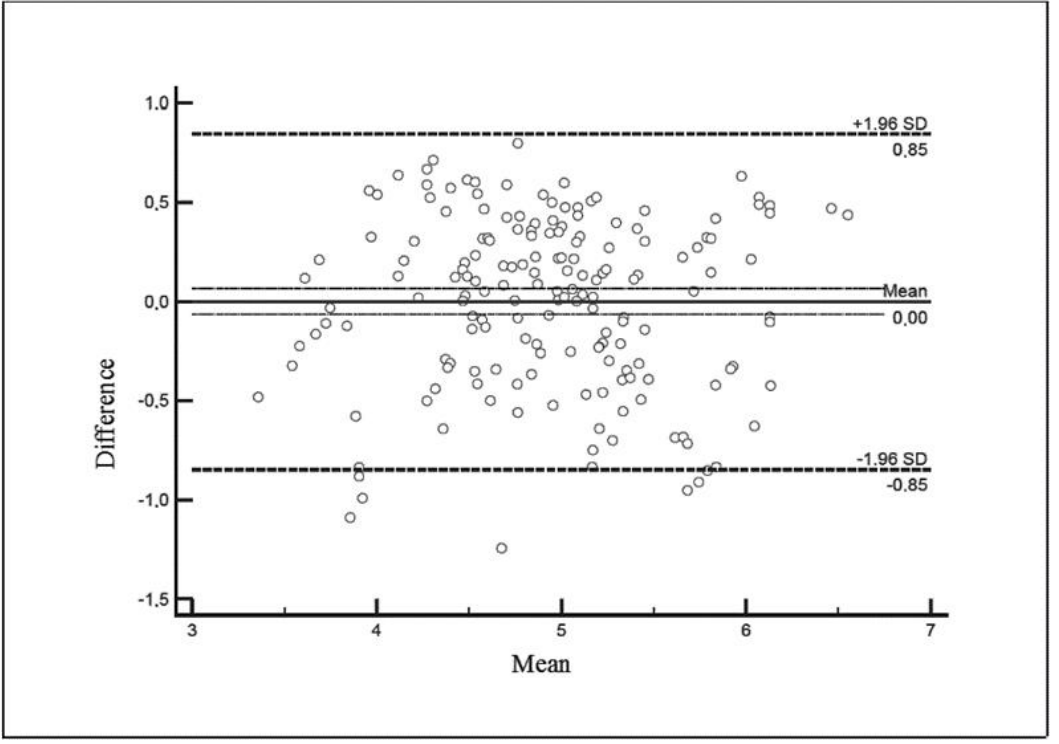
Figure 3. Bland–Altman test. The mean values of the two methods are shown on the X axis. The difference of the two values is shown on the Y axis.